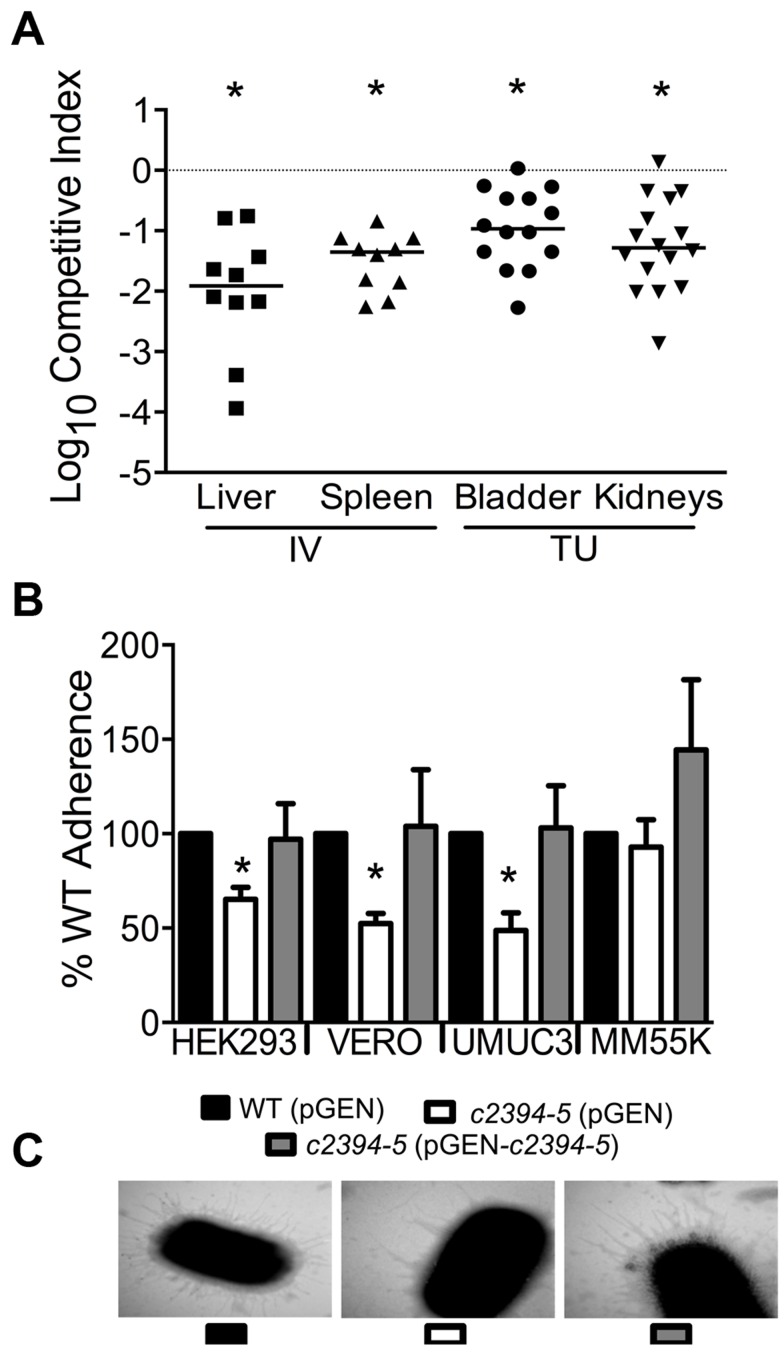
Putative type IV pilus subunit genes are involved in fitness in CFT073.(A) Competitive indices were determined from co-challenge infections with CFT073 and a mutant lacking major and minor type IV pilin genes (c2394-95). Fitness was determined during both systemic infection and UTI and each data point corresponds to results from an individual mouse (*P<0.05, Wilcoxon-signed rank test). IV, intravenous (tail vein); and TU, transurethral. (B) Loss of putative type IV pilin subunits results in reduced adherence to human and monkey kidney cells and human bladder cells. HEK293, human embryonic kidney; VERO, African green monkey kidney; UMUC3, human bladder; MM55K, murine kidney; WT (pGEN), wild-type with empty vector; Δc2394-95 (pGEN), mutant with empty vector; Δc2394-95 (pGEN-c2394-95), complemented mutant. *P<0.05, t test. (C) Electron micrograph of wild-type, mutant and complemented mutant strains. Wild-type and complemented mutant strains express more pili compared to the mutant strain (46,000 X magnification).